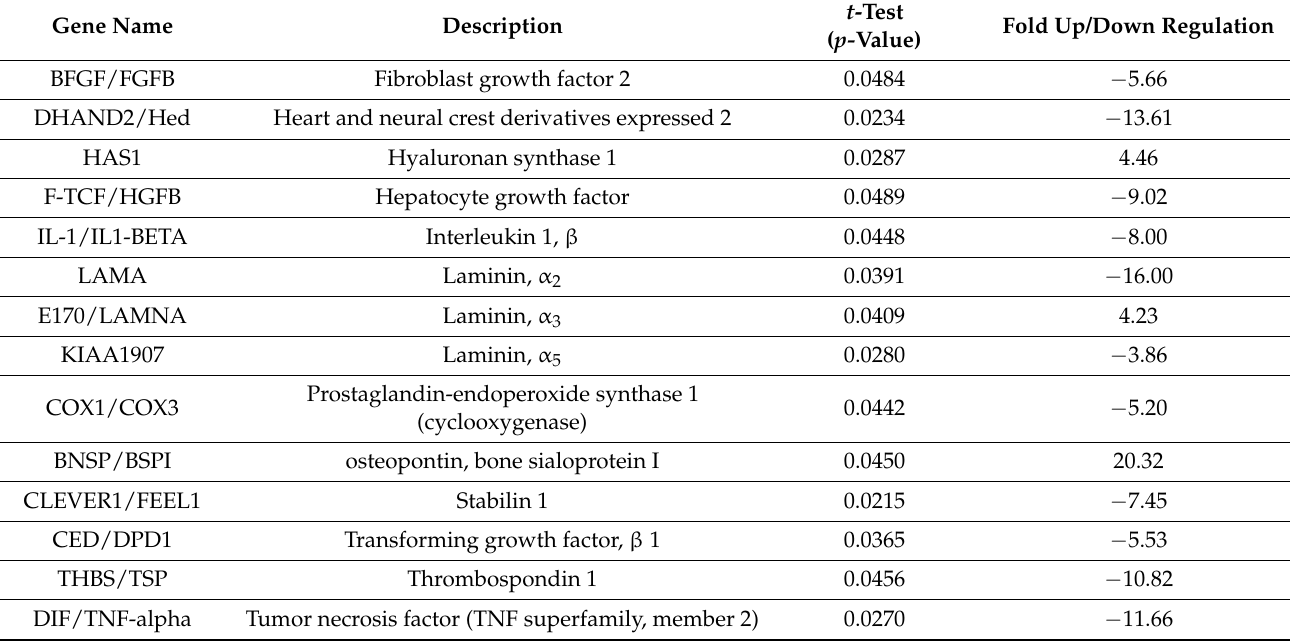
Table 1. Adrenocortical carcinoma versus adenoma significant fold differences in gene expression among 157 molecules